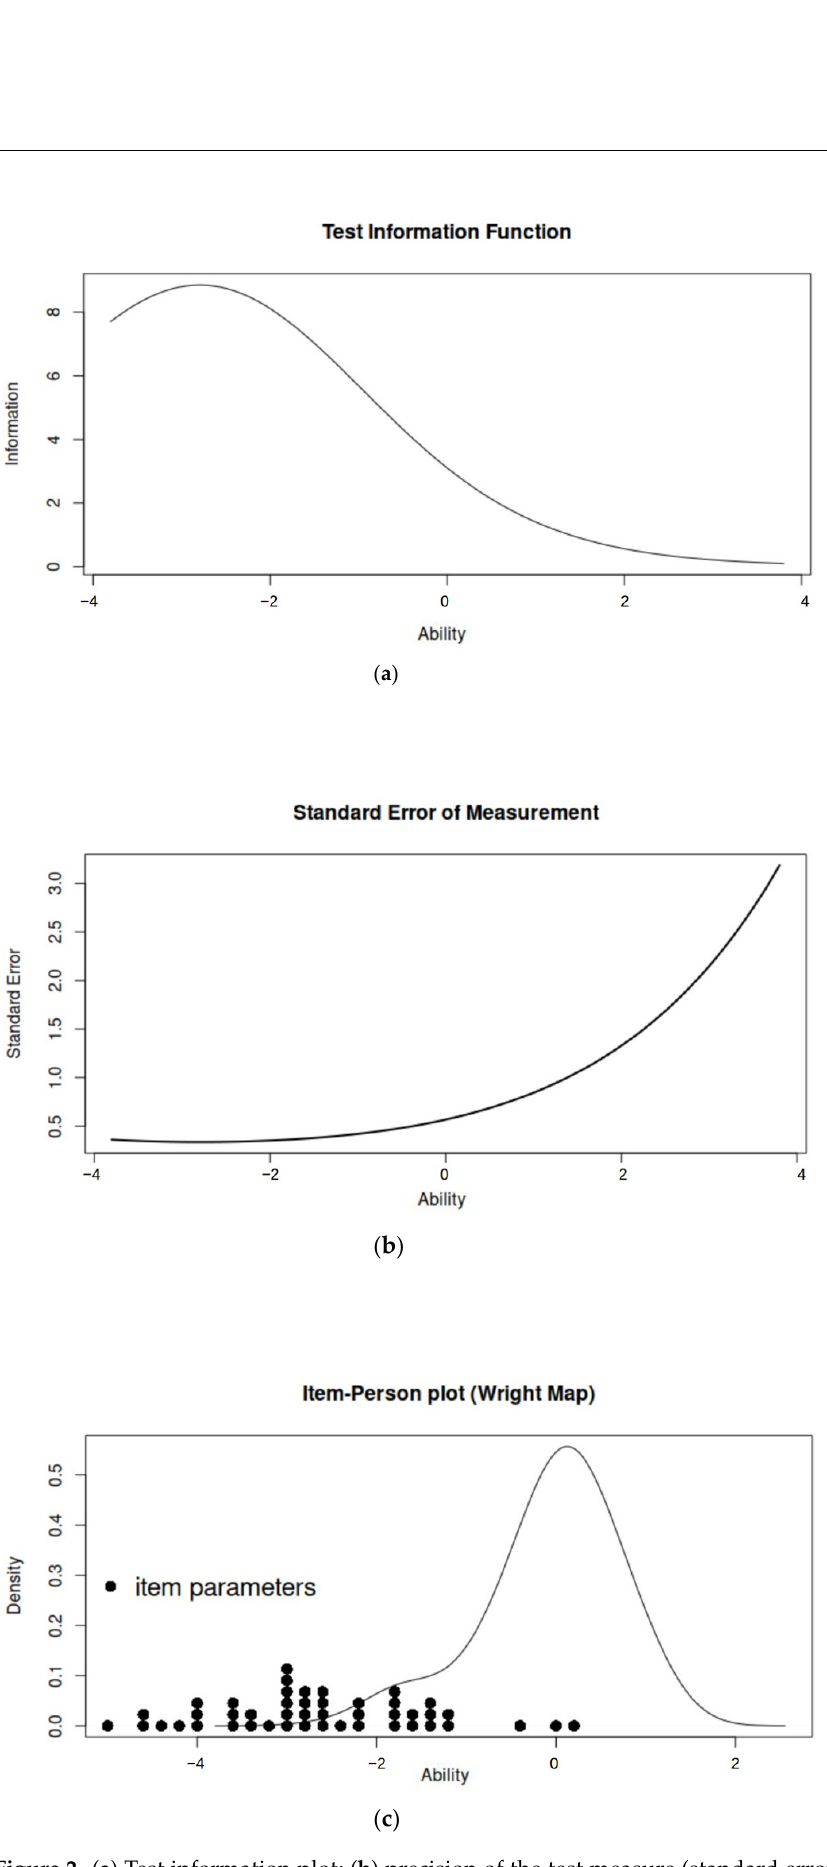
Figure 2. ( a ) Test information plot; ( b ) precision of the test measure (standard error of the test) as function of the estimated cybersecurity vulnerability score; ( c ) item–person plot or Wright